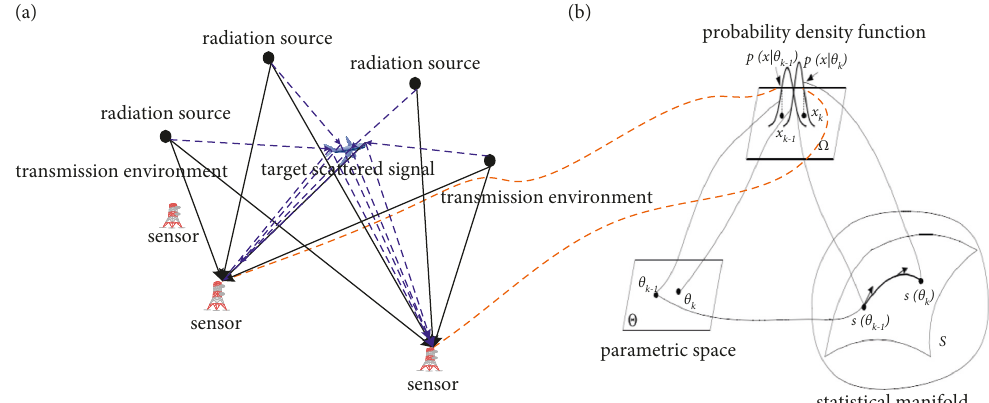
Figure 3: Mapping the sensor network measurement model to a statistical manifold. (a) Collective measurement model. (b) Statistical